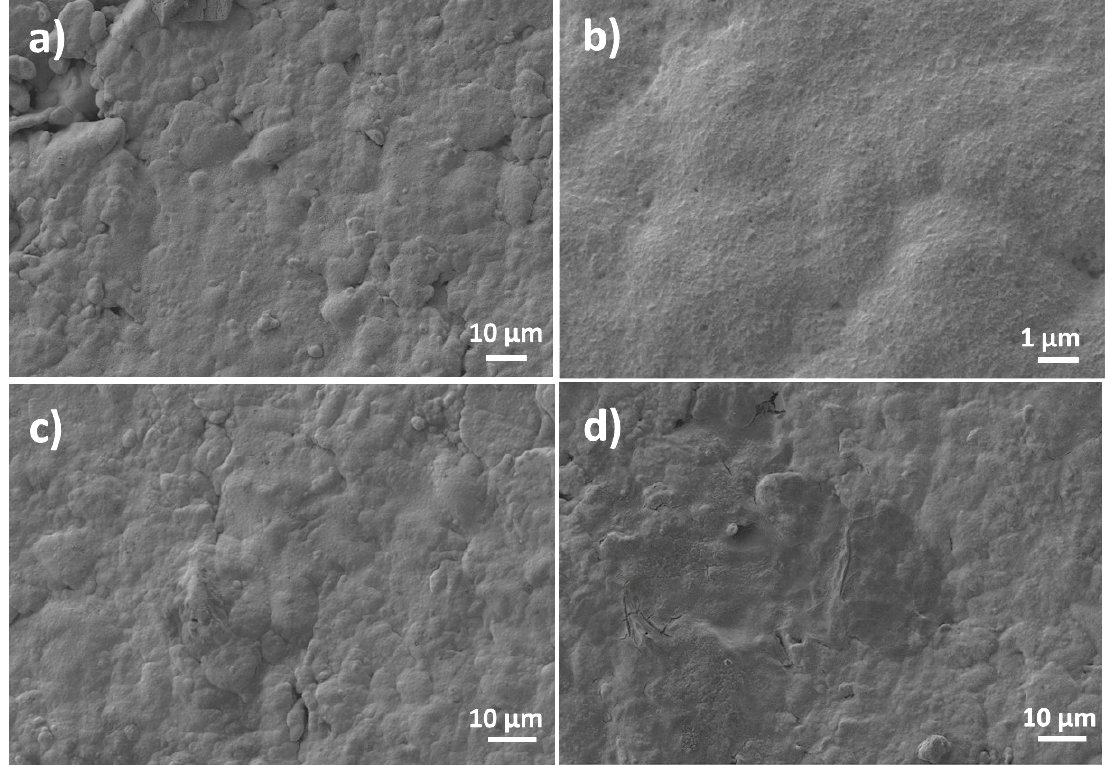
Figure 4. FE-SEM images of the NiMoP electroless coating before ( a , b ) and after modification with GO reduced by the electrochemical approach ( c ) and the chemical approach ( d ).